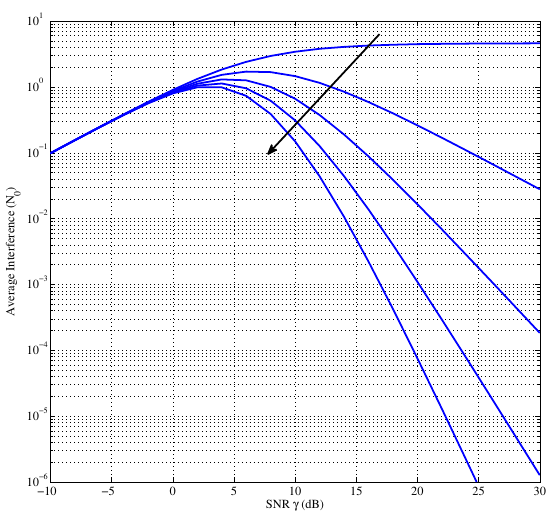
Figure 7. The efficiency-oriented scheme for HCoS with I ≤ N k = N 0 . Along the direction of the arrow, N = 1 , 2 , 3 , 4 , 5